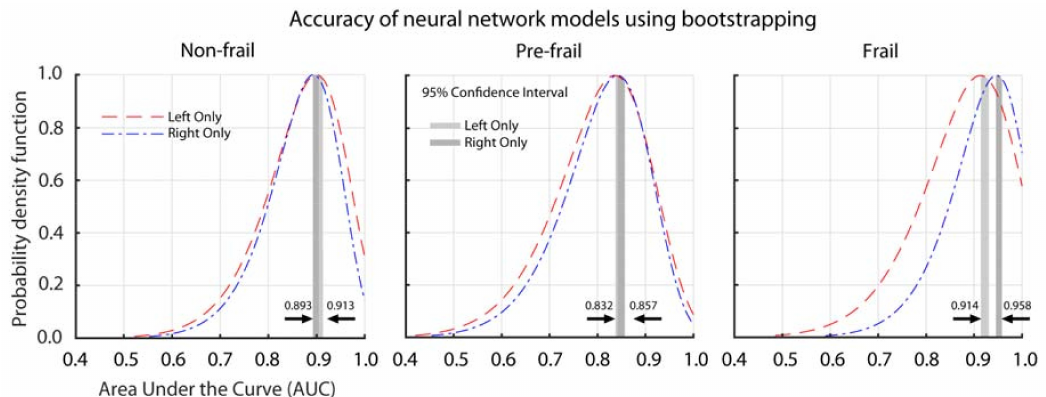
Figure 4. Probability distribution function the Area under the Curve (AUC) of two different sensor configurations. The confidence interval (shaded region) was calculated using bootstrapping (iteration = 500). The upper and lower limit of the confidence interval of the sensor configuration are also